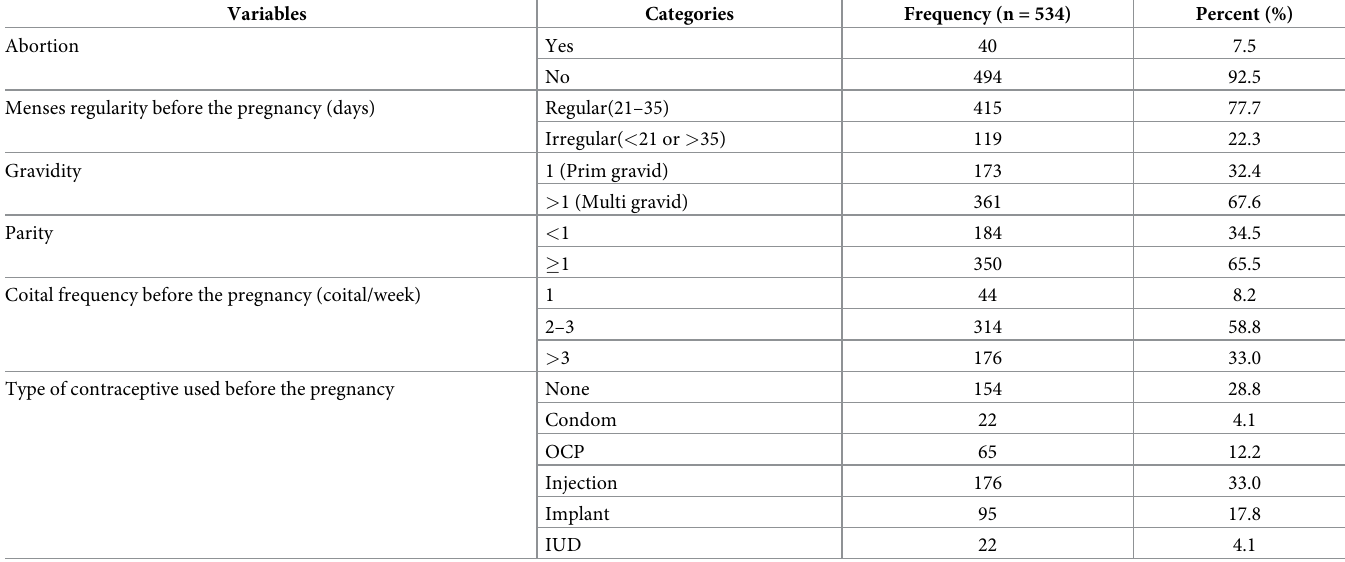
Table 3. Reproductive health-related factors of mothers with natural planned conception attended ANC service at AMHFs,